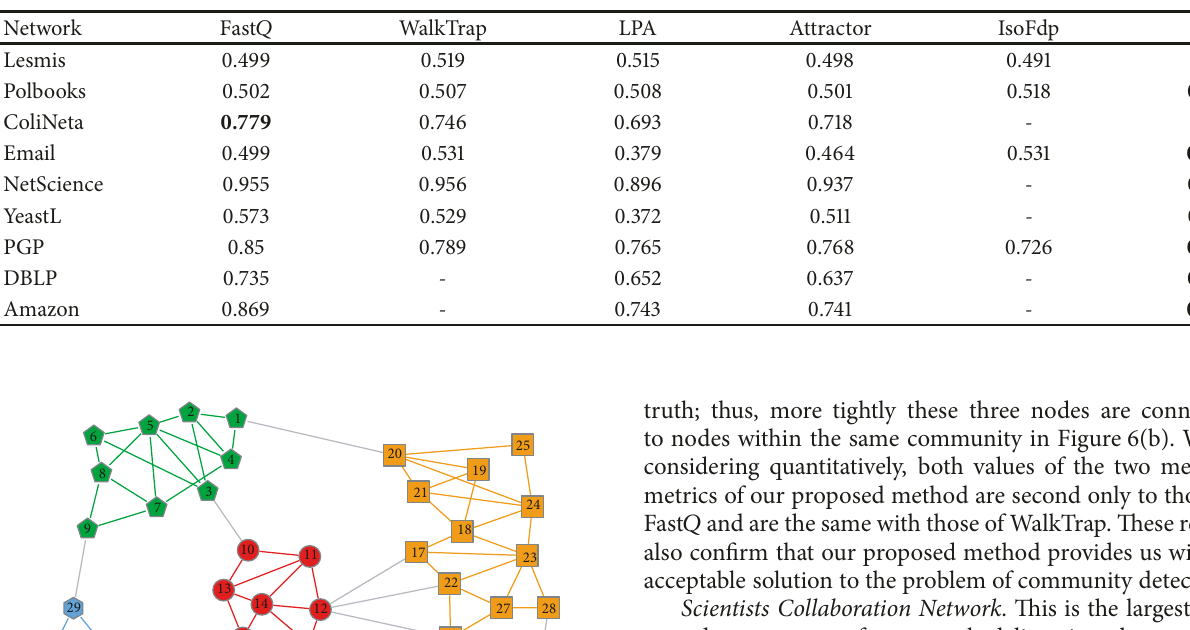
Table 4: The experimental results of modularity on networks. The largest values of the two measure metrics are typed in bold.